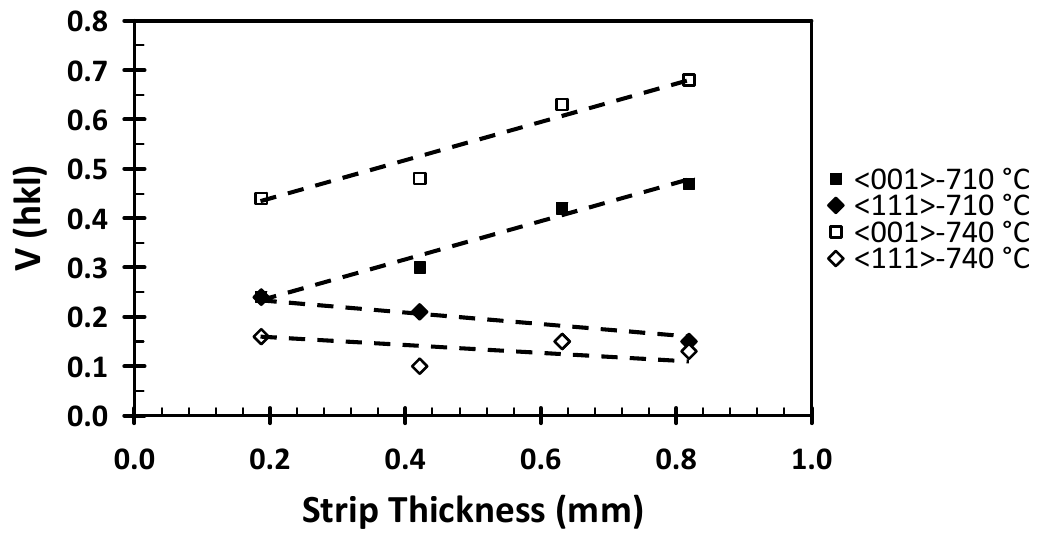
Figure 13. Effect of temperature of annealing prior to cold rolling on V(001) and V(111) for material finally annealed at 700 °C for 3 min.